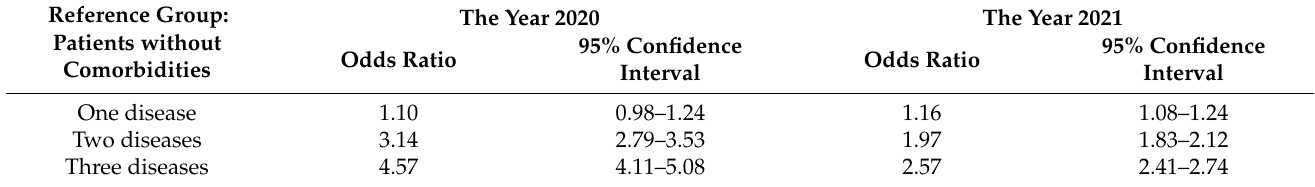
Table 2. The odds ratio explained the risk of death in COVID-19 patients according to the number of coexisting diseases.